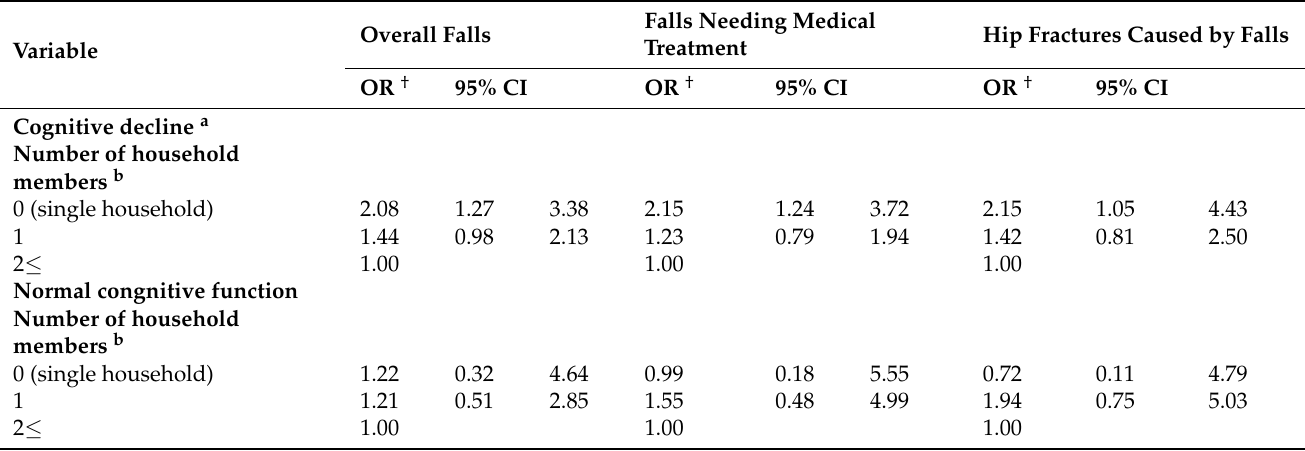
Table 3. Odds ratios for occurrence of overall falls, falls needing medical treatment and falls resulting in hip fractures according to number of family members in household according to cognitive